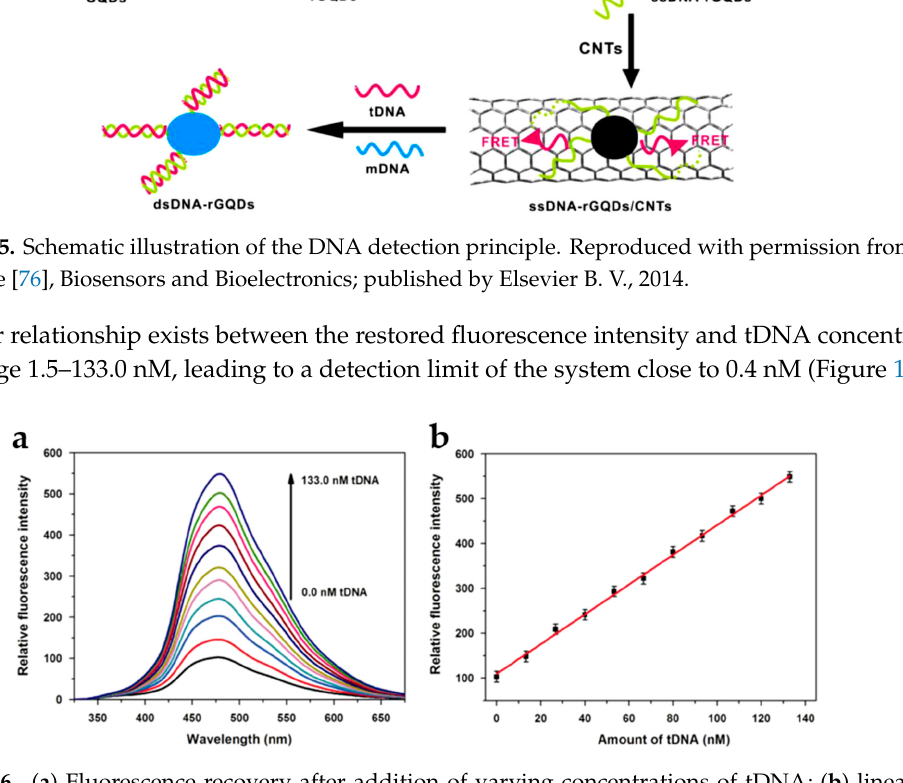
Figure 16. ( a ) Fluorescence recovery after addition of varying concentrations of tDNA; ( b ) linear relationship between fluorescence recovery and tDNA concentration. Reproduced with permission